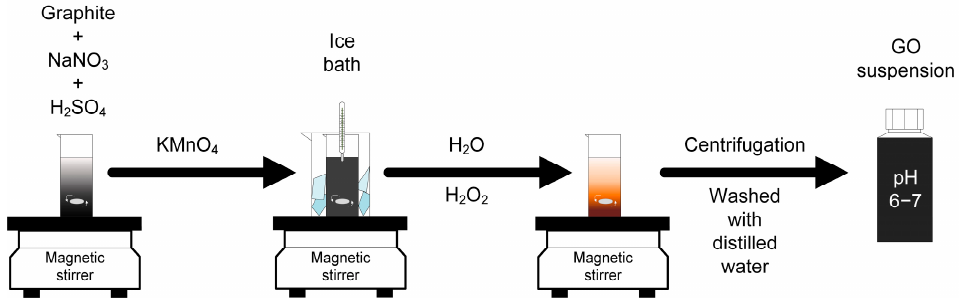
Figure 2. Schematic illustration of the modified Hummers method for synthesis of graphene oxide. Concentrated sulfuric acid was added to a mixture of commercial graphite and nitric